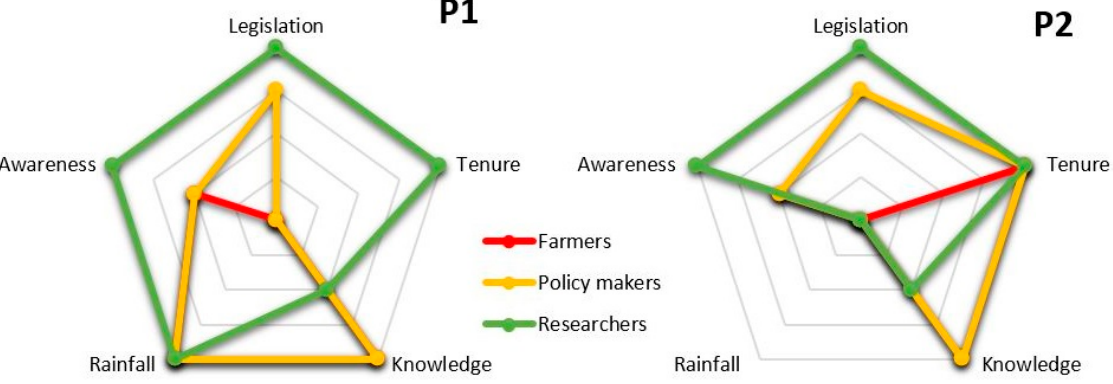
Figure 3. Main barriers to the adoption of sustainable practices by group. P1 (harvesting and storage of rainwater, practice 1); P2 (desalination of seawater, practice 2).